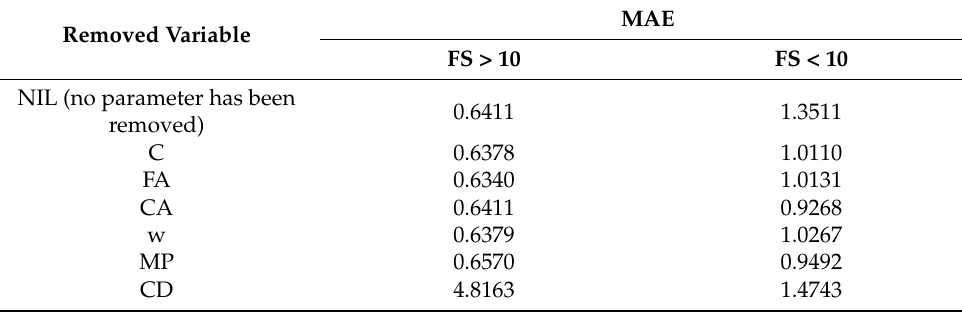
Table 13. GP-based sensitivity model results for FS < 10 and FS >